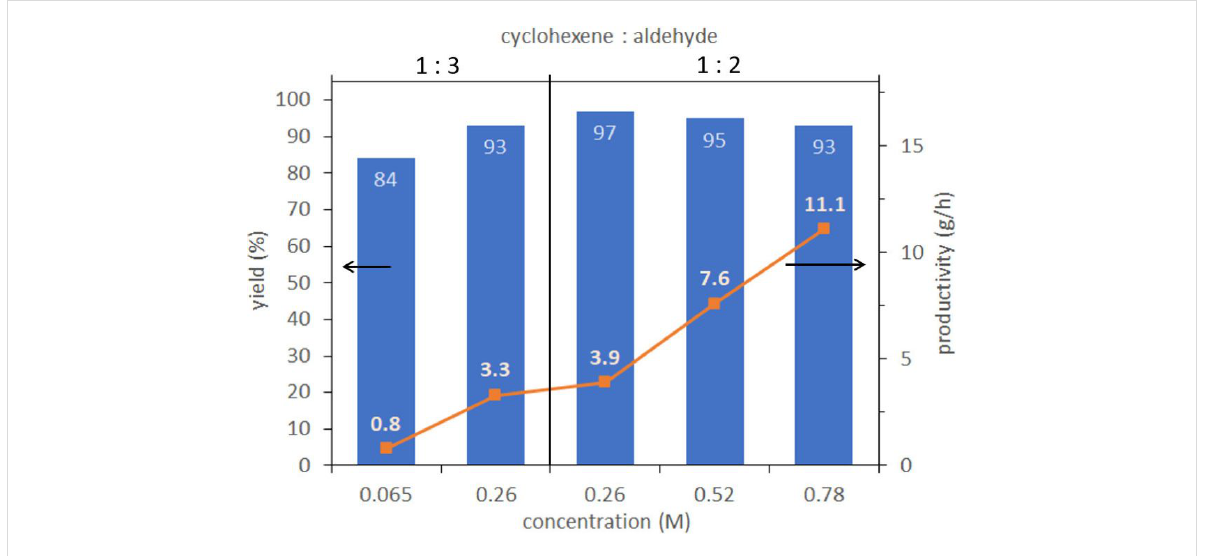
Figure 6: Effect of concentration of cyclohexene and eqivalent of